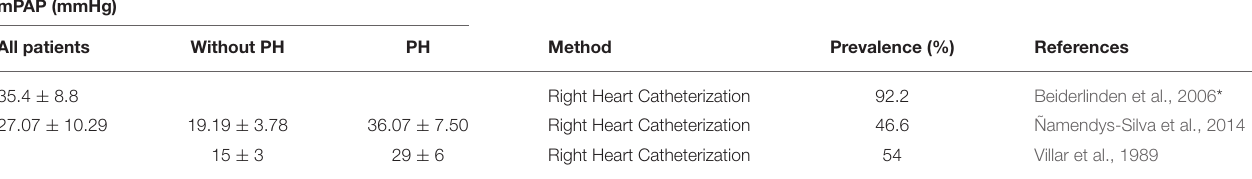
* individual mPAP values for patients with and without PH not provided.